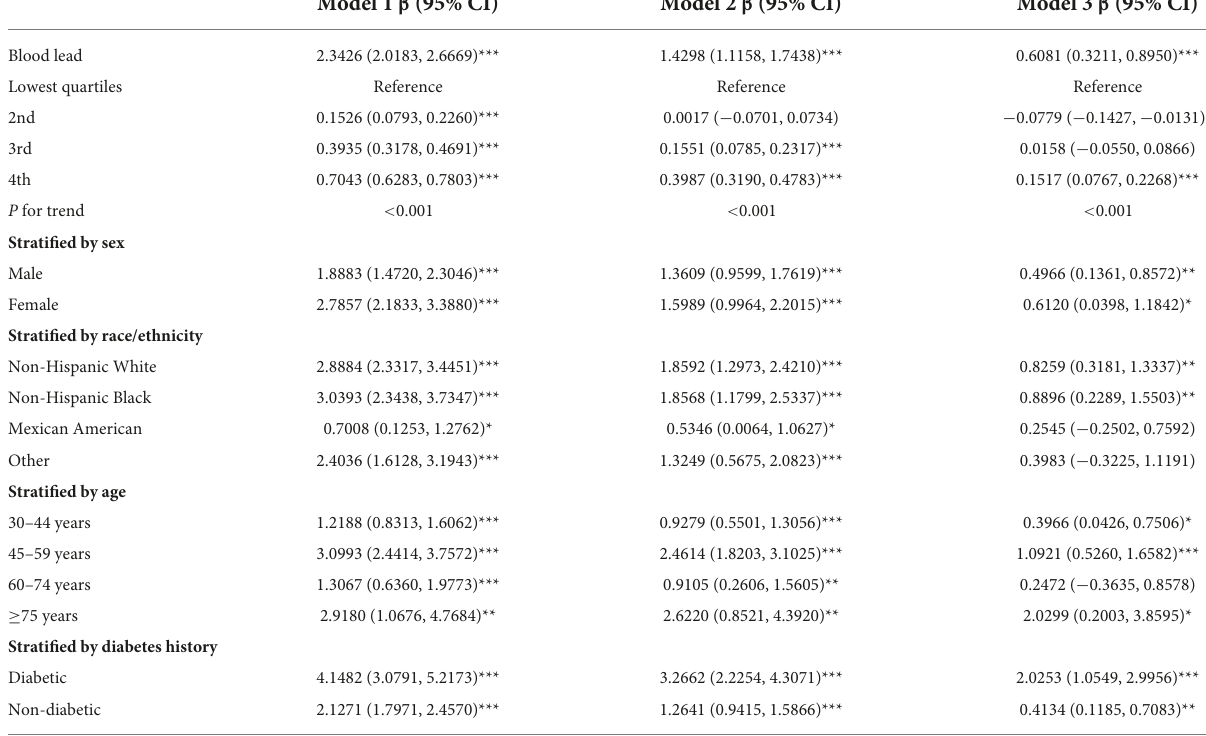
TABLE 4 Association between blood lead concentration ( µ mol/L) and CAL (mm), and stratified by sex, race/ethnicity, age and diabetes